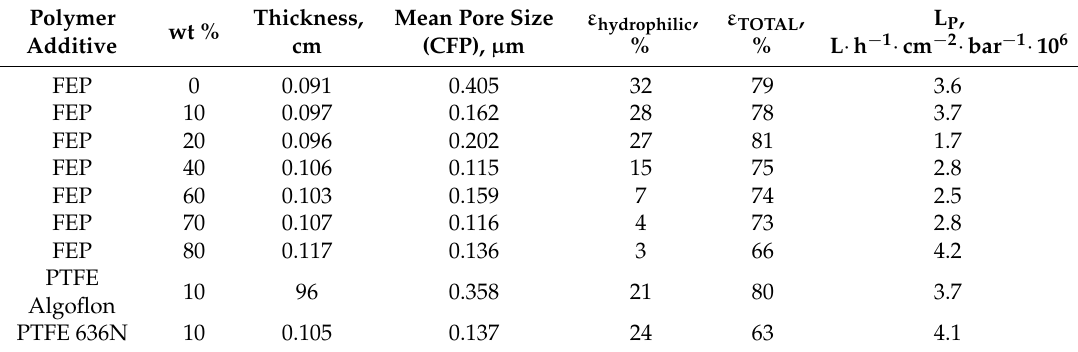
Table 4. Effect of the additional polymers on the properties of the